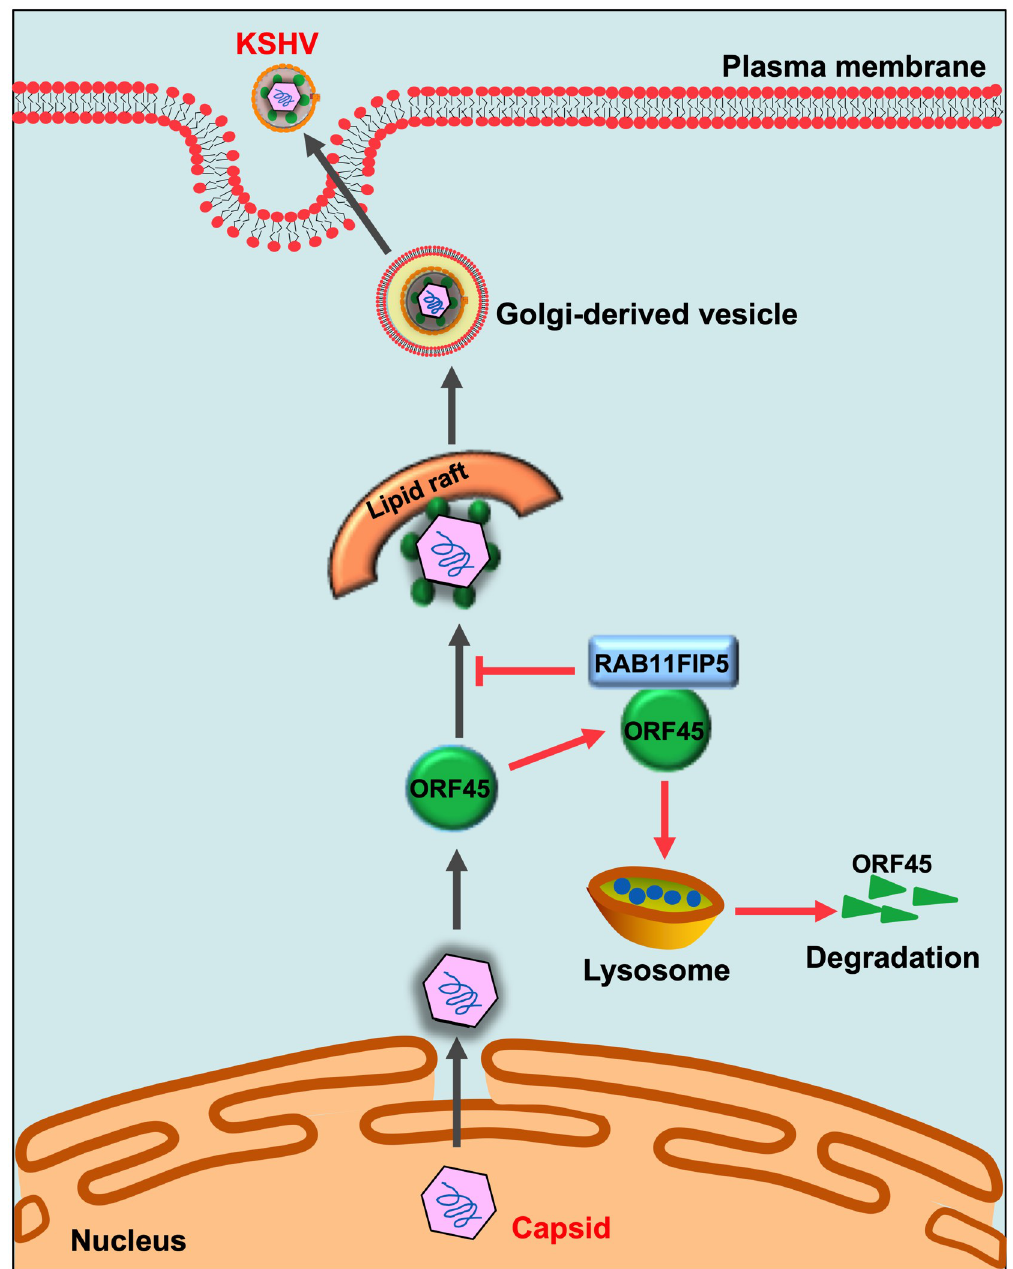
Fig 9. Working model indicating the role of RAB11FIP5 in ORF45-mediated release of KSHV particles. After budding into the cytoplasm, the tegument protein ORF45 directs tegumented capsids to LRs in the Golgi apparatus and promotes the release of KSHV particles. The host protein RAB11FIP5, a novel ORF45 binding protein, promotes the translocation of ORF45 to lysosomes and increases lysosome-dependent degradation of the ORF45 protein, which impairs the colocalization of ORF45 with LRs in the Golgi apparatus and then impairs the release of KSHV particles through Golgi transport vesicles.